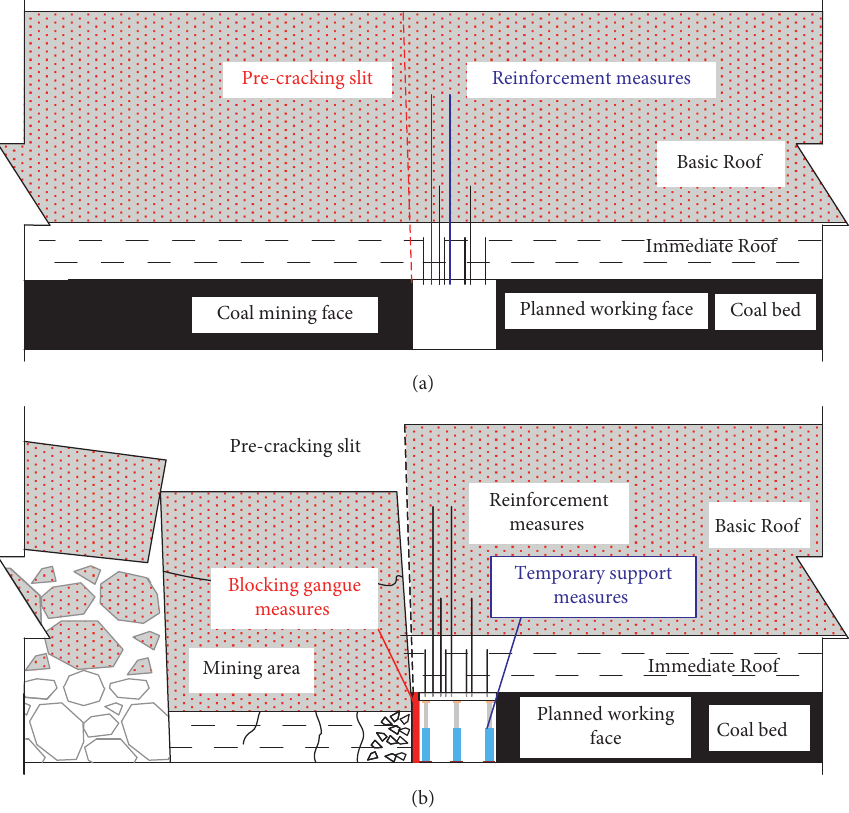
Figure 4: Technical principle of roof cutting and pressure relief retaining roadway along goaf. (a) Roof cutting and reinforcement support shall be carried out before mining. (b) Gangue retaining and temporary support after